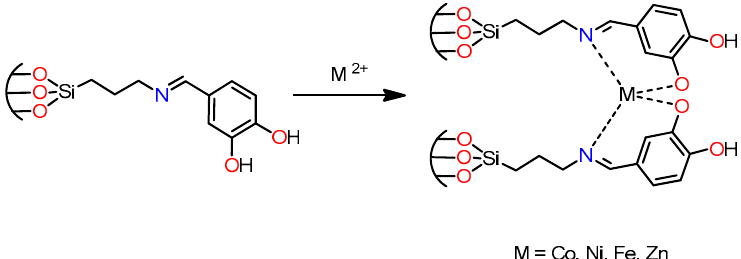
Figure 36. Preparation of ordered MCM-41 mesoporous silica containing Cobalt, Niquel, Iron, and Zinc Schiff base complex.